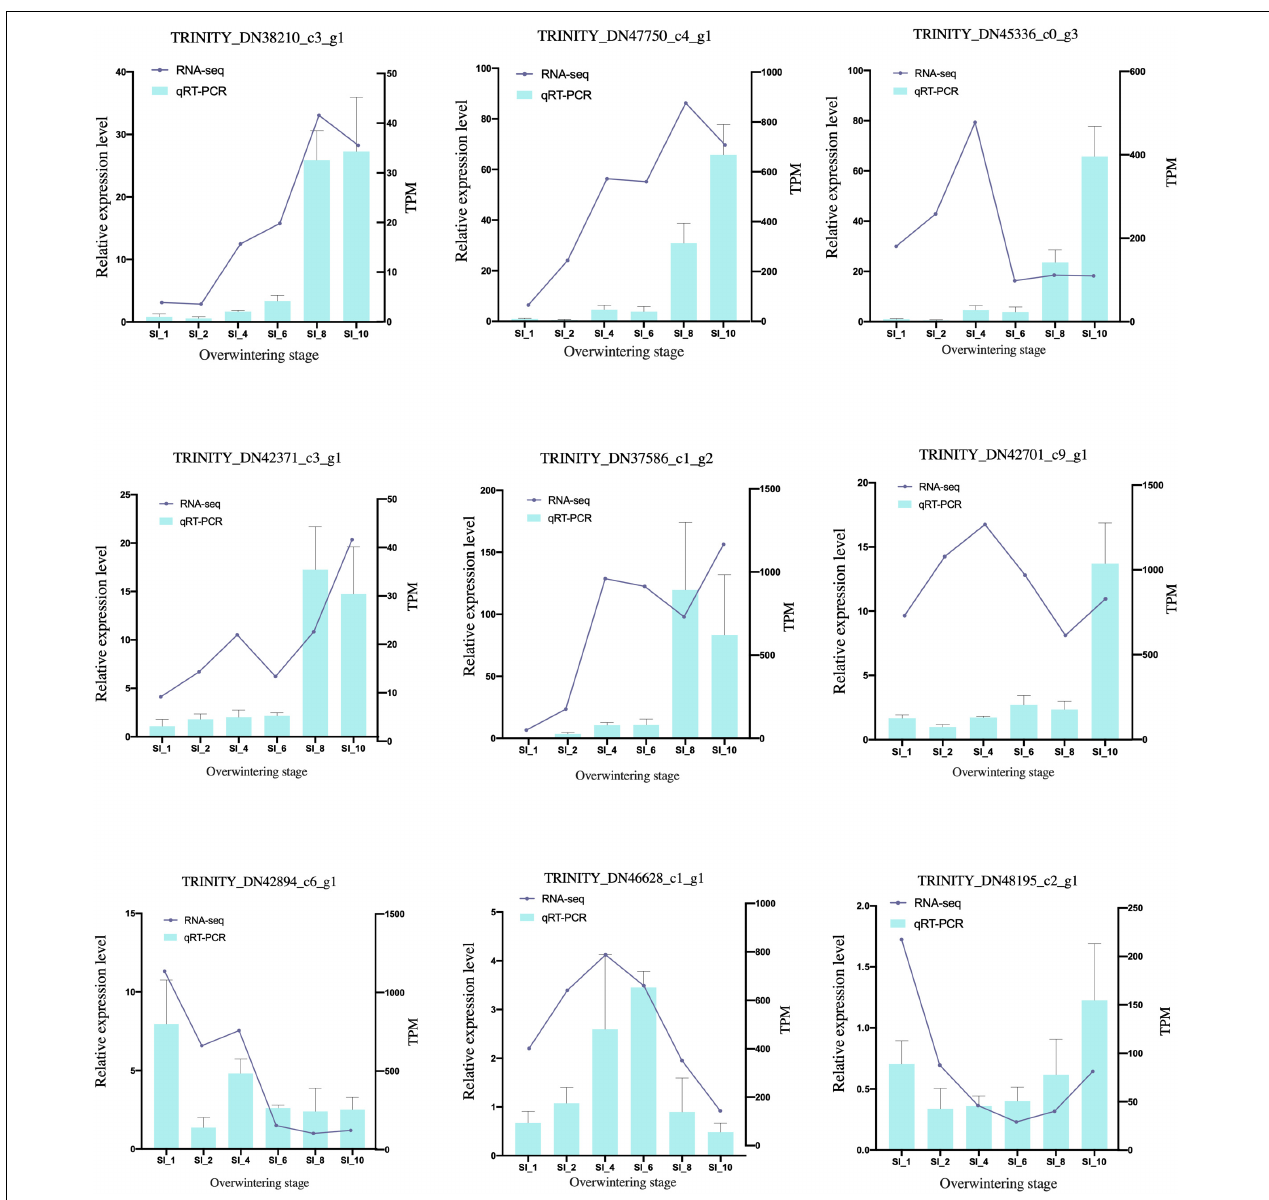
FIGURE 1 | qRT-PCR validation of candidate genes. The qRT-PCR results (blue columns) were compared with RNA-seq data (purple lines). The relative expression level of qRT-PCR is shown on the y-axis to the left; and the normalized expression level (TPM) of RNA-seq is indicated on the y-axis to the right. SI_13 was set as control